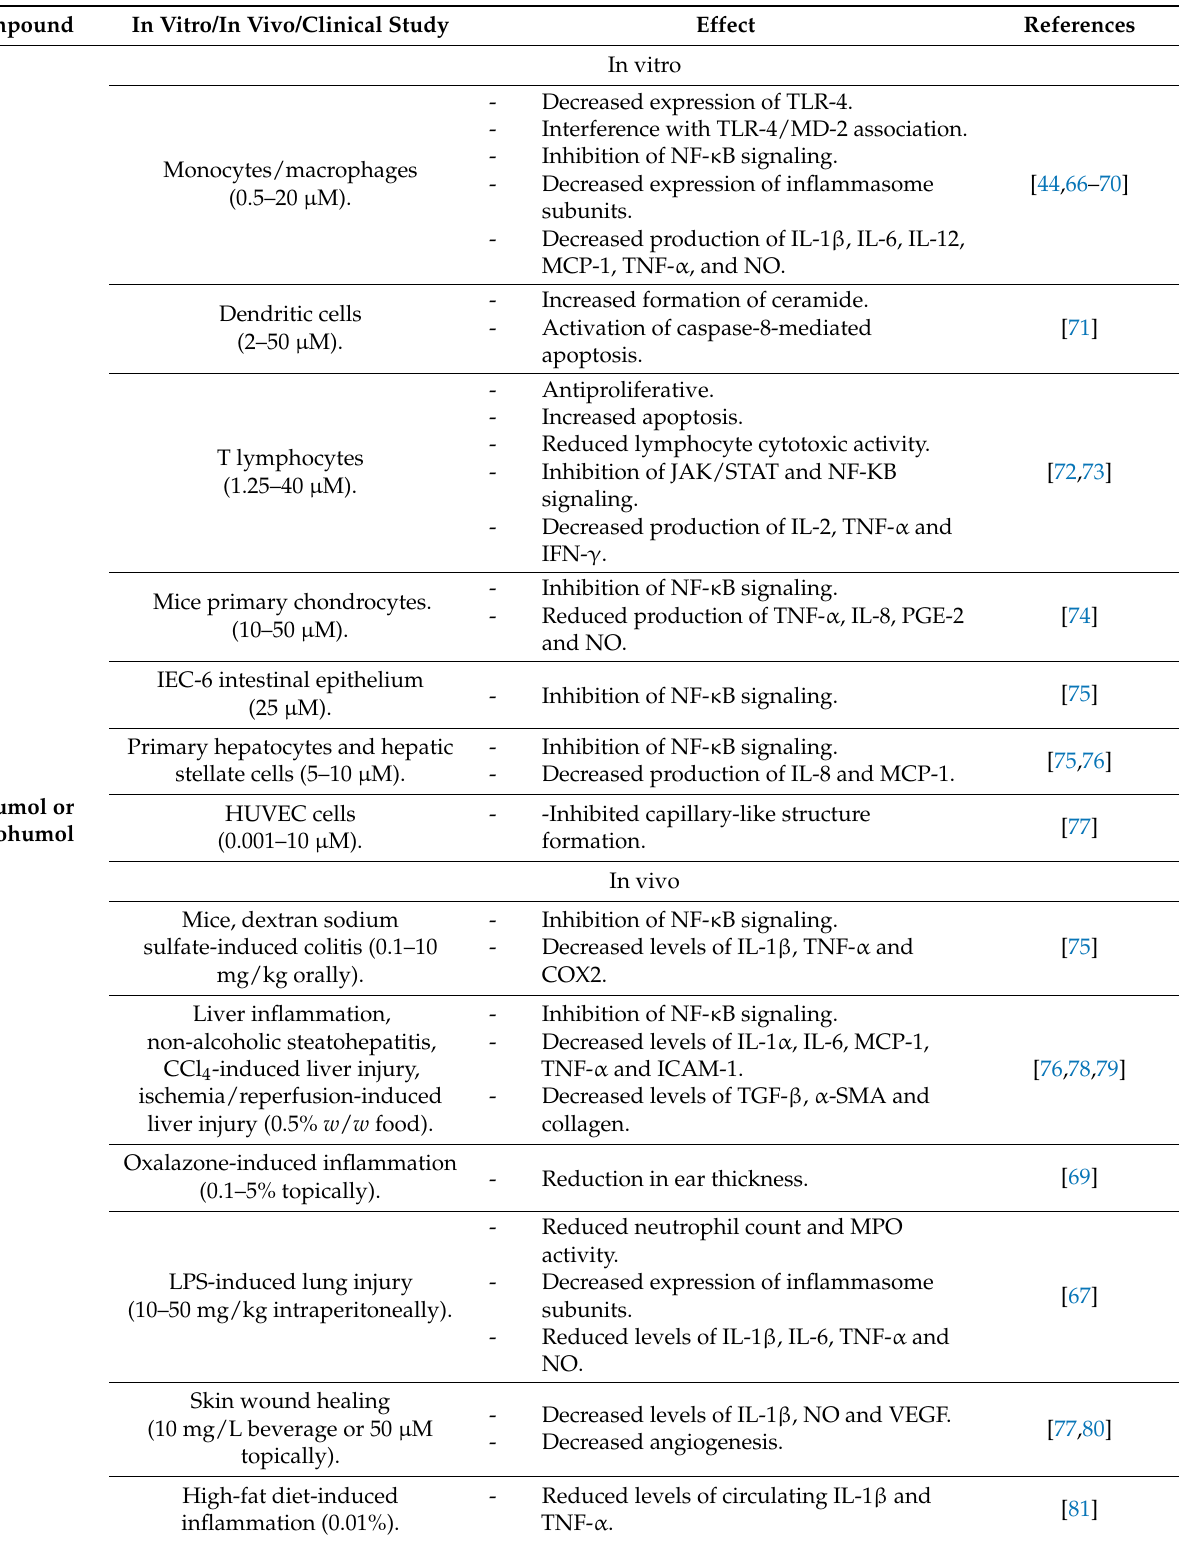
Table 1. Effects of beer compounds on